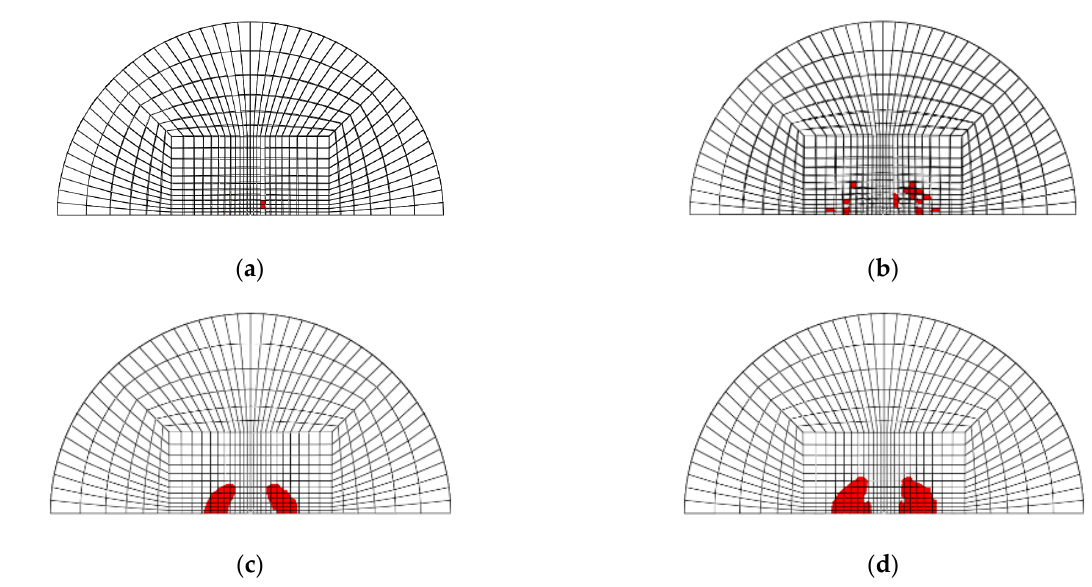
Figure 20. Fiber tension failure (FTF) in the composite layers of GLARE 5-2/1 with [0 ° /90 ° /90 ° /0 ° ] after applying the first impact energy of 8 J; ( a ) 2D failure model (0.392 ms), ( b ) 2D failure model (3.66 ms), ( c ) 3D failure model (0.392 ms); ( d ) 3D failure model (3.66 ms).